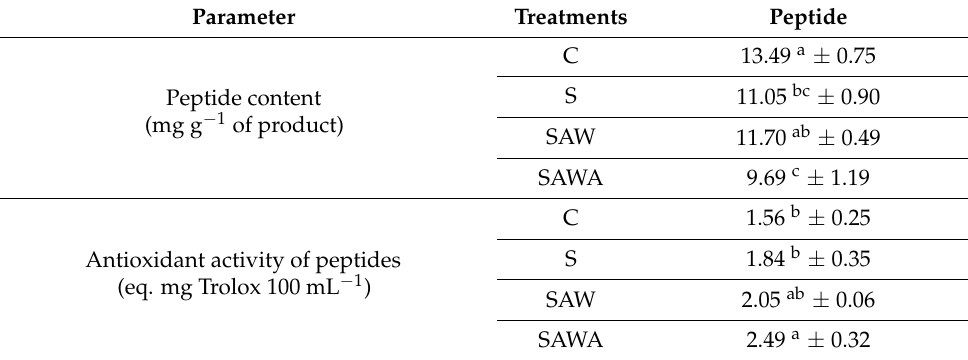
Figure 1. Loadings for the two principal components. TP—total pigment content, HI—heme iron content, PI—proteolysis index, TN—total nitrogen content, NPN—non protein nitrogen. Table 6. Content and antioxidant activity of peptides isolated from dry fermented sausages at the end of manufacturing (21 day) (mean ±